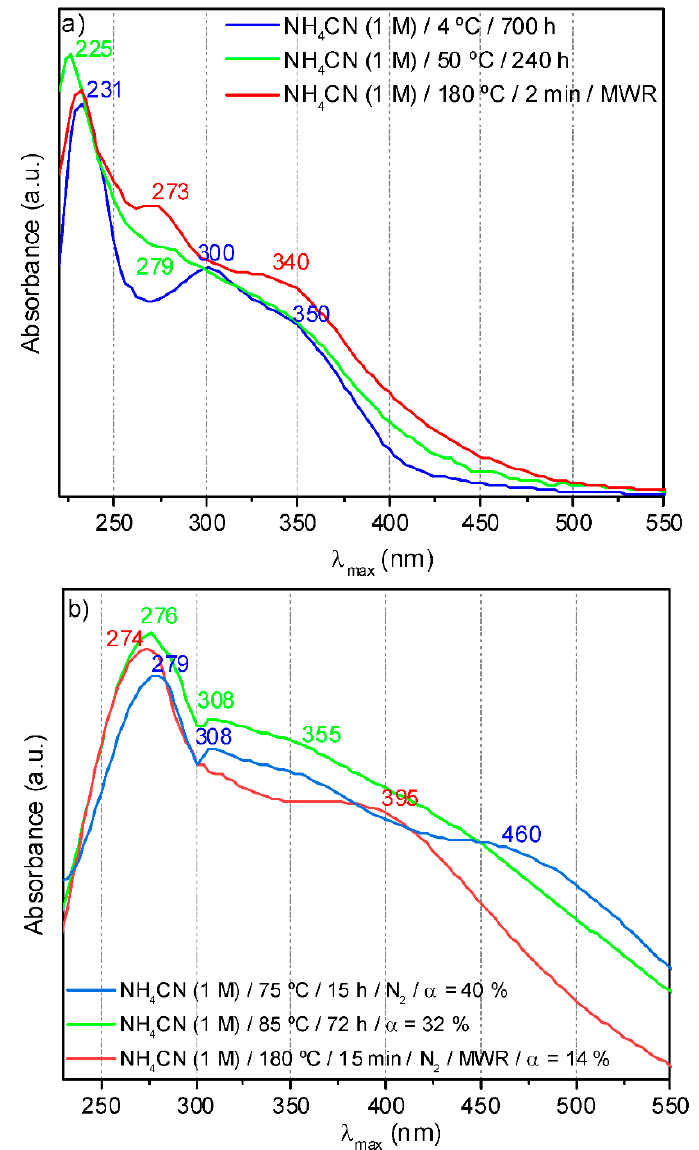
Figure 8. UV-vis spectra: ( a ) Sol fractions; ( b ) gel fractions obtained under different synthetic conditions. MWR = microwave radiation. N 2 = reaction carried out under inert atmosphere of nitrogen. Air was present in the rest of reactions.